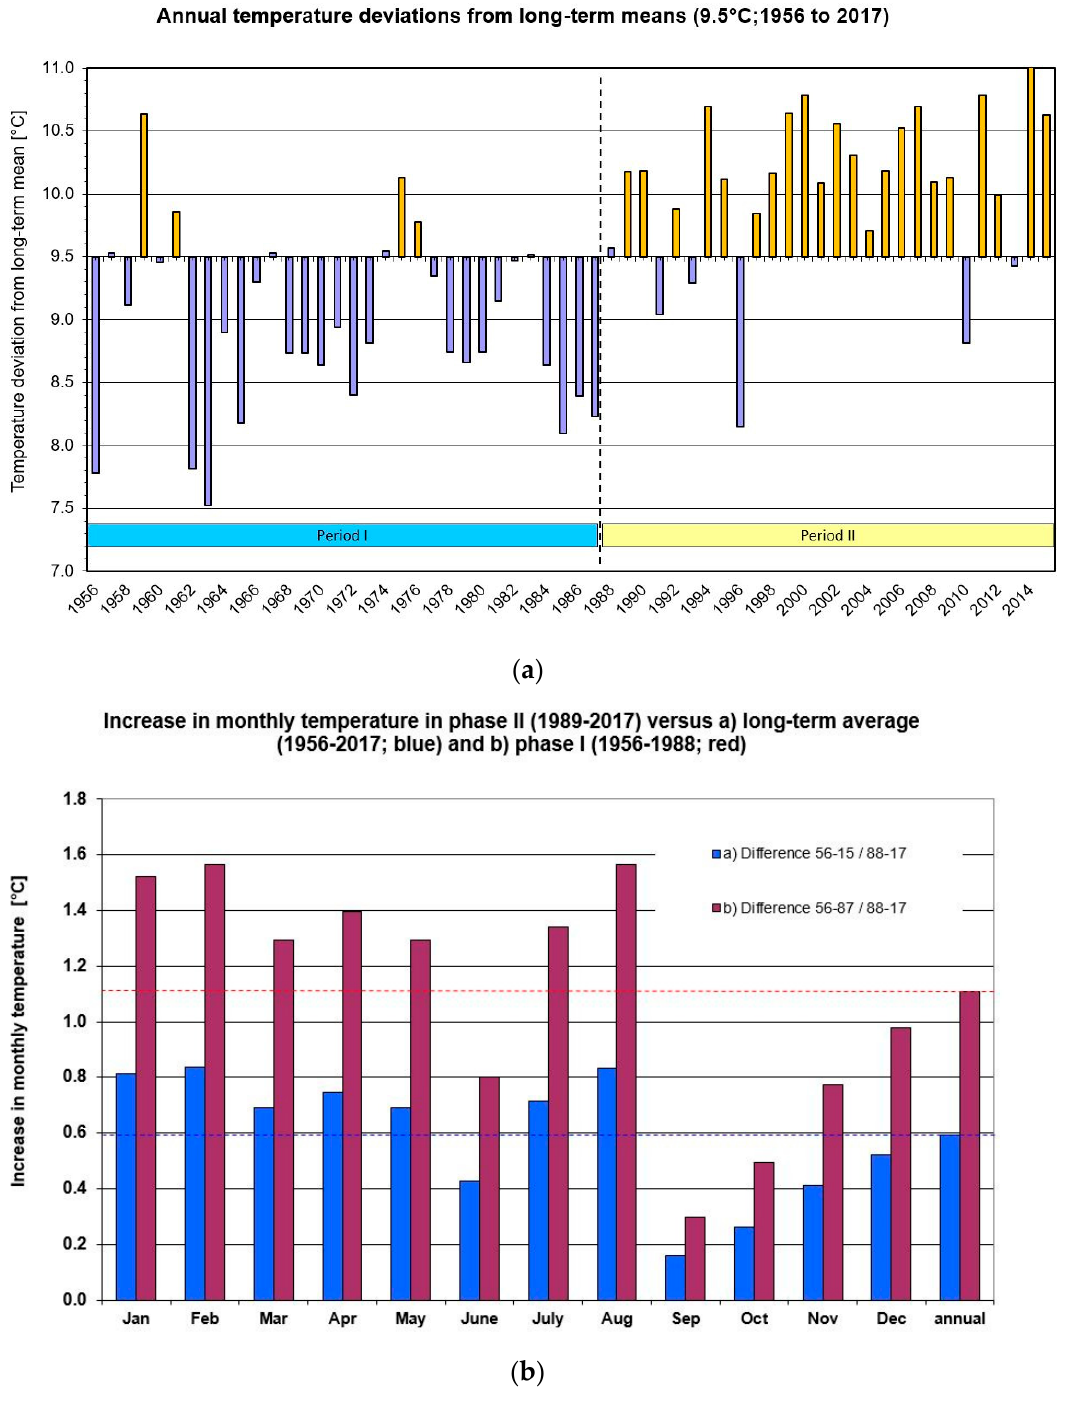
Figure 1. ( a ) Annual deviation from the 60-year (1956–2017) temperature average (9.5 °C); the dotted vertical line indicates the transition between phase I and phase II and ( b ) increase in monthly temperatures of phase II (1988–2017) relative to phase I (1956–1987) and to the long-term average (1956–2017) (red horizontal line).